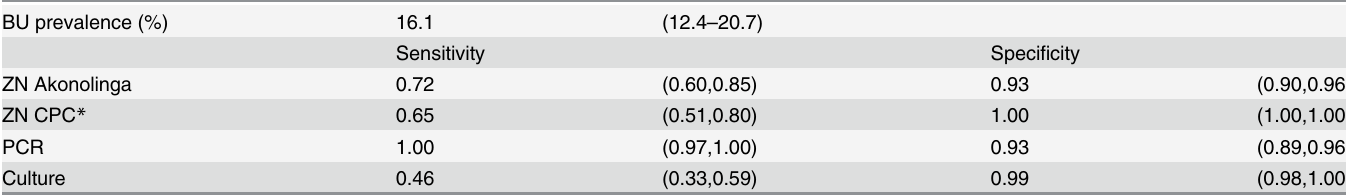
Table 2. Parameter estimates from latent class analysis (N = 325).